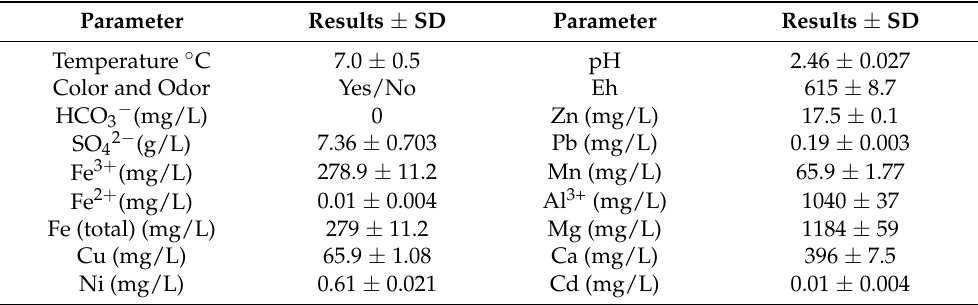
Table 1. Physical and chemical properties of AMD from Lake Robule.